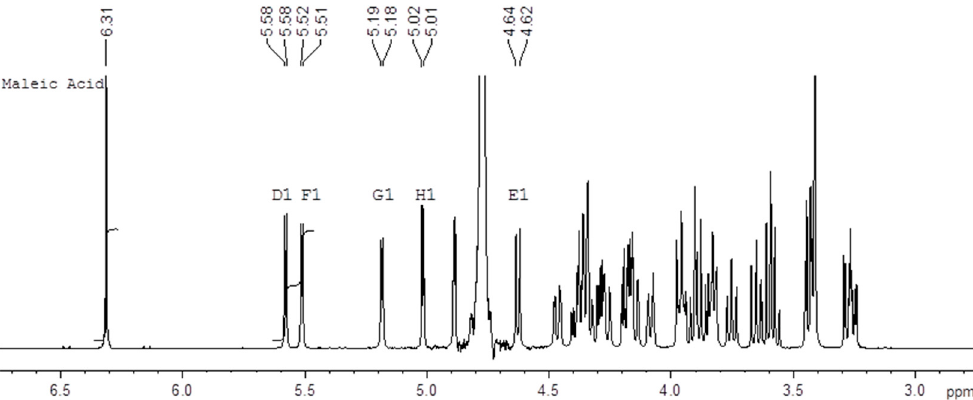
Figure 2. Example of the 500 MHz 1 H-NMR spectrum of a mixture of the Fondaparinux sodium standard and maleic acid in D 2 O with the relevant integrated signals.